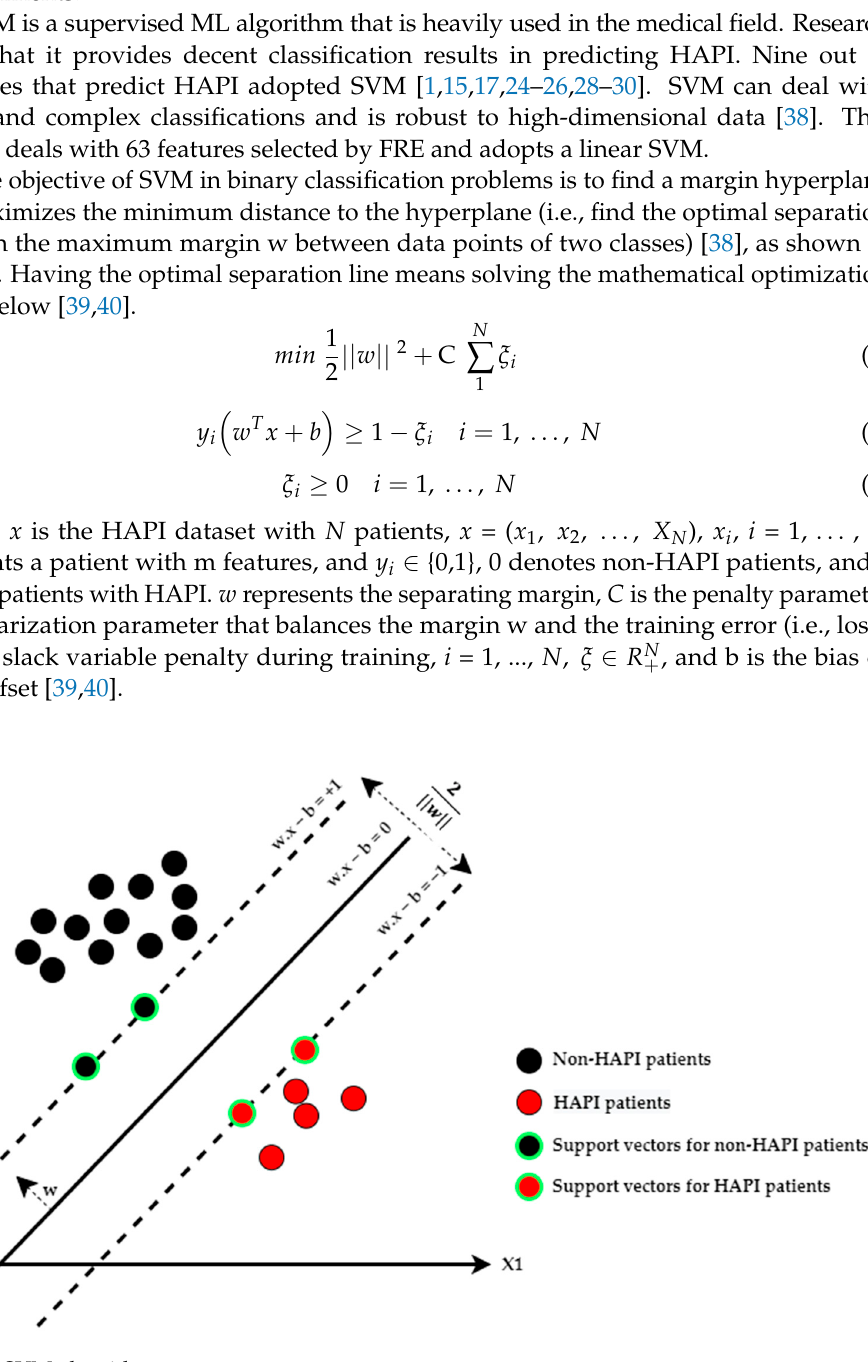
Figure 3. SVM algorithm.